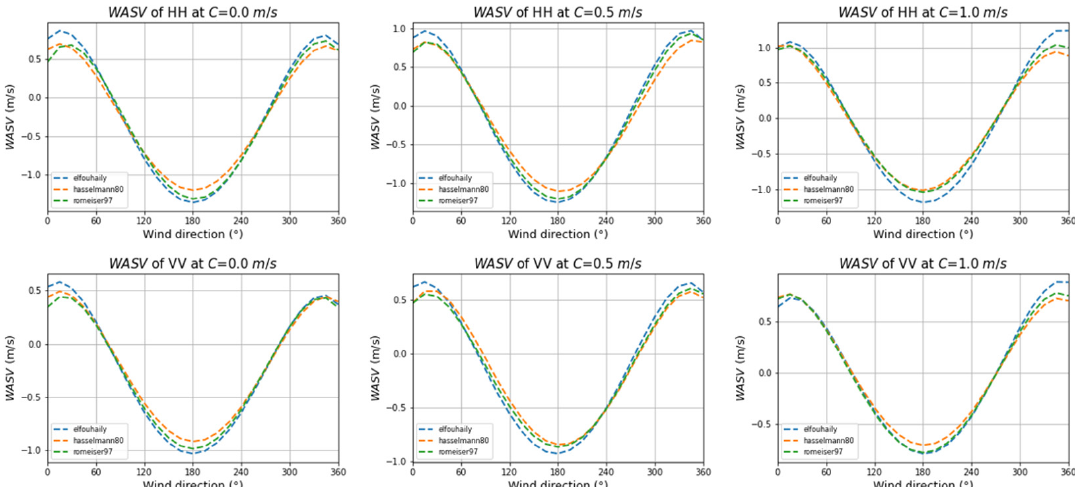
Figure 15. The relationship between WASV and wind direction for different spreading functions and current velocities. Wind speed and direction were 10 m/s and 0°, respectively. Swell amplitude, direction, and wavelength were 0.5 m, 0°, and 200 m, respectively. The spreading function is indicated by color: blue indicates the E spreading function, yellow indicates the H spreading function, and green indicates the R spreading function. The omnidirectional wave spectrum is the typical directional function of the E spreading